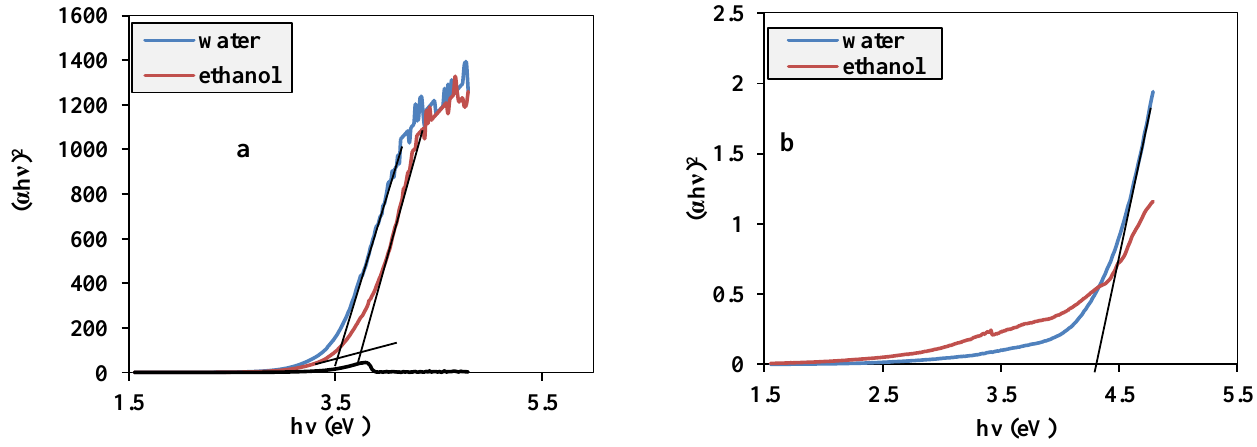
Figure 4: energy gap plots of (αhv)2 versus hv of lithium-niobate suspension (a) LN pellet, (b) LN wafer.